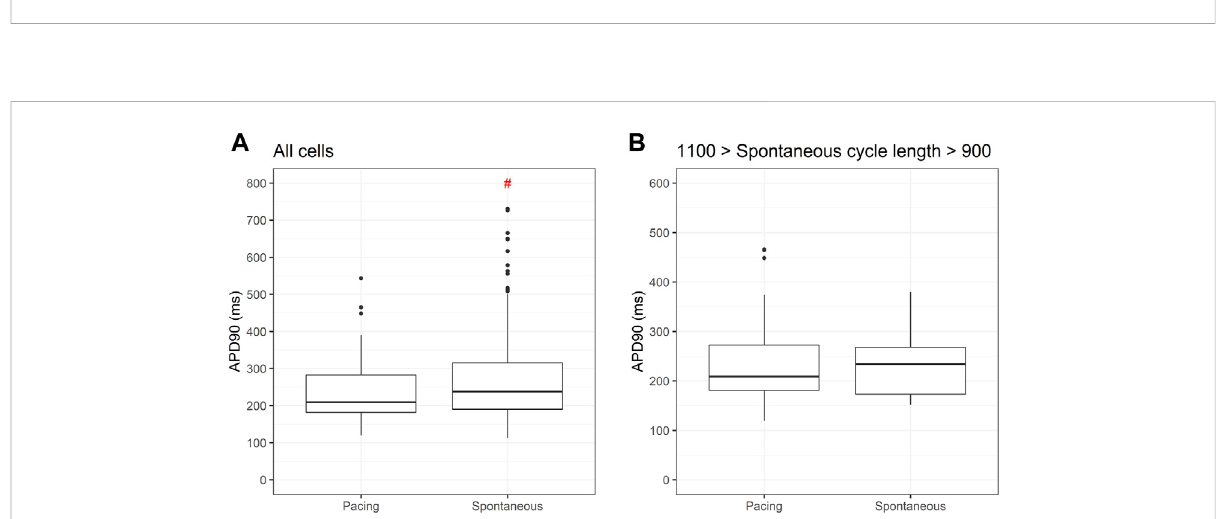
Action potential duration at 90% repolarization (APD90) under spontaneous and pacing conditions. Box plots in (A) shows signi fi cant differences in APD90 between PSC-derived cardiomyocytes beating spontaneously and paced at 1 Hz. In (B) , using only spontaneous cycle lengths varying between 0.9 and 1.1 Hz, similar values for APD90 are obtained under both